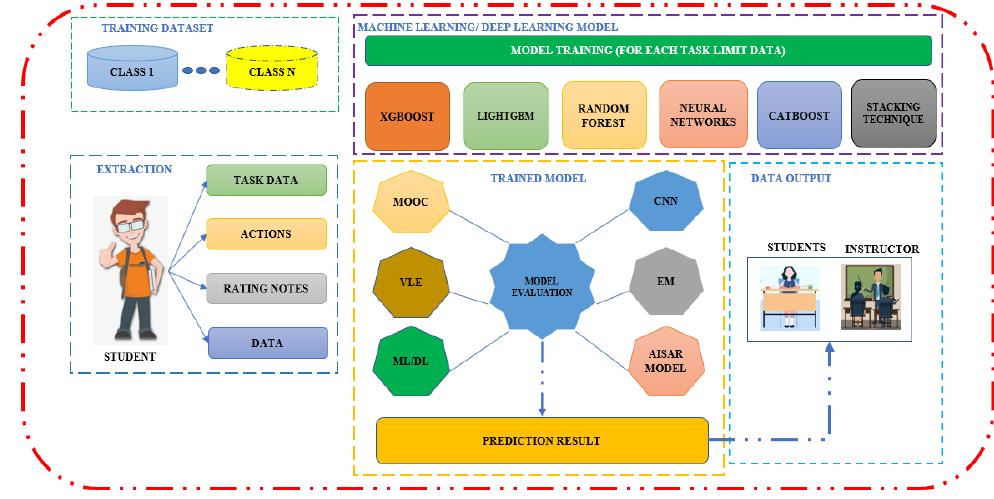
Figure 2. Techniques applied in different papers related to student engagement.